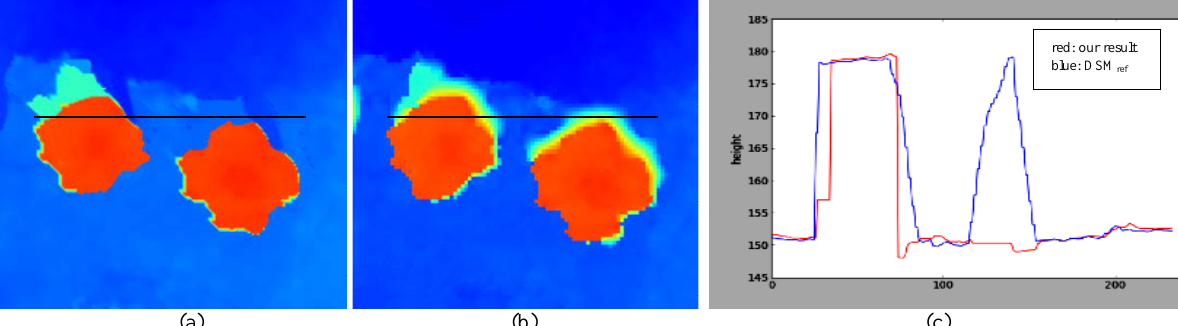
Figure 9. The visual comparison of the two profiles (c) derived from our result (a) with the given DSM (b).